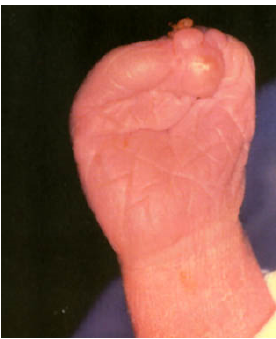
Figure 2. Amputation of digits with a constricting amniotic band as an example of disruption.